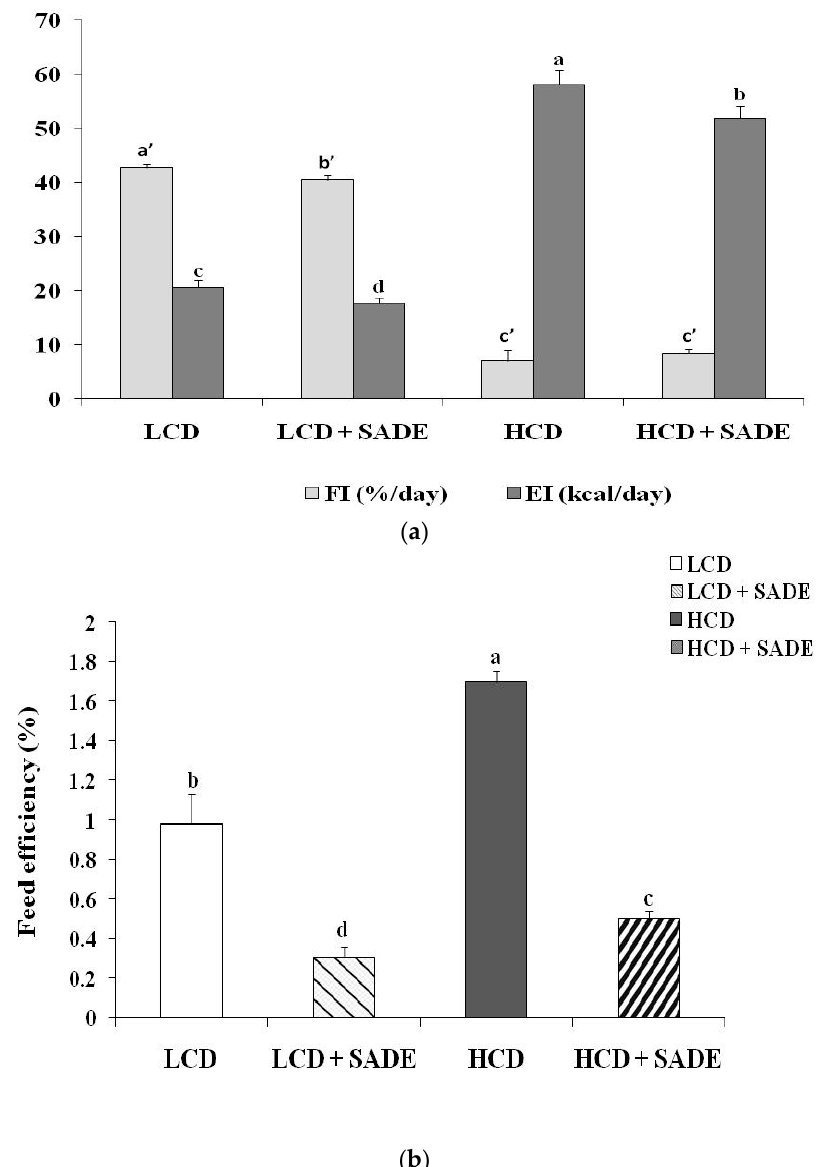
Figure 1. ( a ) Effect of SADE on average food intake (FI) and energy intake (EI) in P. obesus . LCD: group fed with natural low-calorie vegetable diet, LCD + SADE: LCD group treated with S. arabica decocted, HCD: rats fed with high-calorie diet and HCD + SADE: rats fed with high-calorie diet treated with S. arabica decocted extract. Results are presented as means ± SD for ten rats in each group. Means not sharing the same superscript letters (a, b, c, d, a’, b’, c’) are significantly different between groups (Tukey’s post hoc test, p < 0.05). “a” denotes the highest value, and “d” represents the lowest value for EI. “a’” denotes the highest value and “c” represents the lowest value for FI. ( b ) Effect of SADE on average feed efficiency, FE in P. obesus . LCD: animals group fed with natural low-calorie vegetable diet, LCD + SADE: control treated with S. arabica decocted, HCD: rats fed with high-calorie diet and HCD + SADE: rats fed with high-calorie diet treated with S. arabica decocted extract. Results are presented as means ± SD for ten rats in each group. Means not sharing the same superscript letters (a, b, c, d) are significantly different between groups (Tukey’s post hoc test, p < 0.05). “a” denotes the highest value and “d” represents the lowest